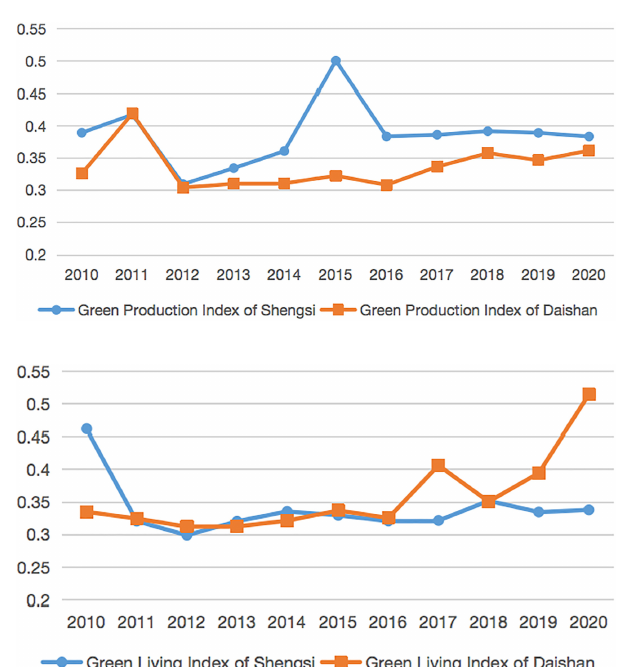
Figure 4. 2010 – 2020 green living index evaluation